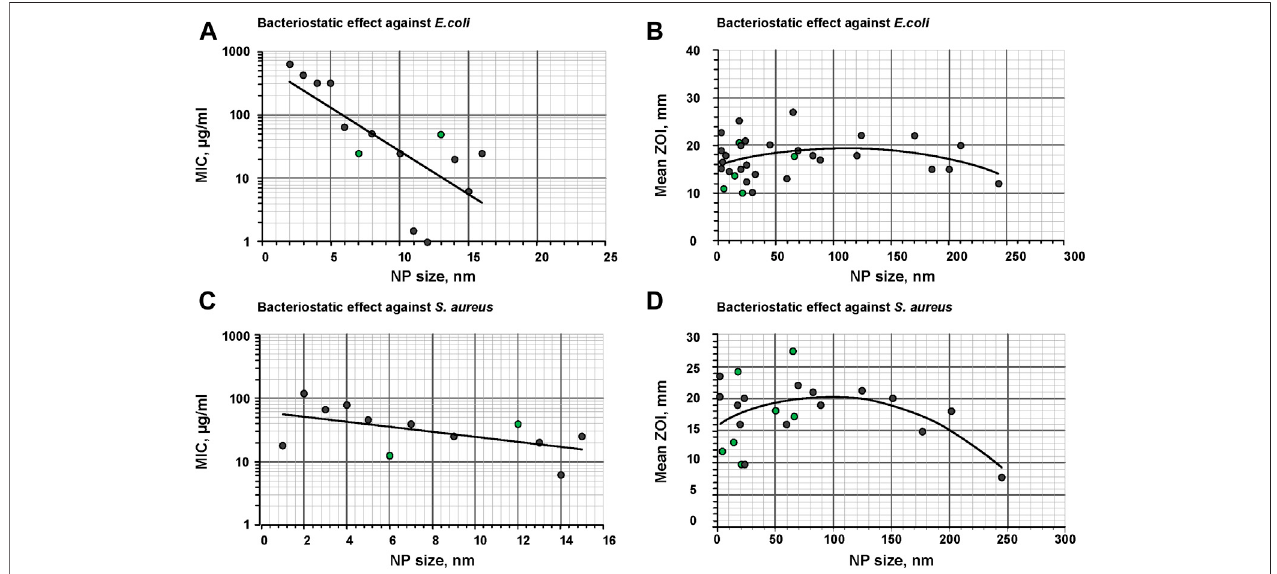
FIGURE1| DependenceoftheminimuminhibitorycapacityonthesizeofNP-ZnO,aswellasthedependenceofthesizeofthezoneofinhibitiononthesizeofNP- ZnO against gram-negative bacteria by the example of E. coli (A and B) and gram-positive bacteria by the example of S. aureus (C and D) . Gray dots are samples synthesized by methods without using “ green synthesis ” , green dots are samples obtained using “ green synthesis ”